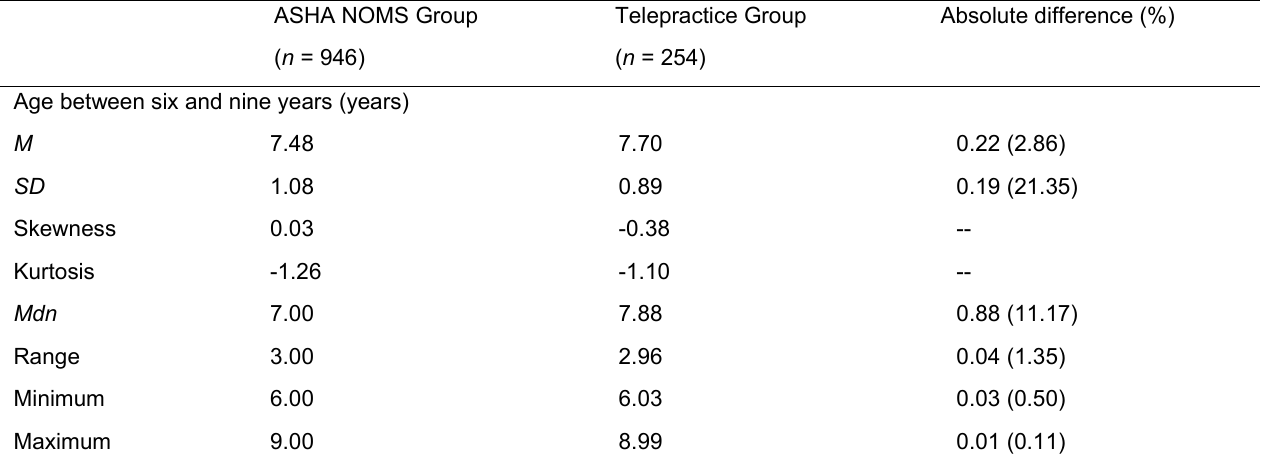
Telepractice Group Absolute difference (%) ( n = 254)